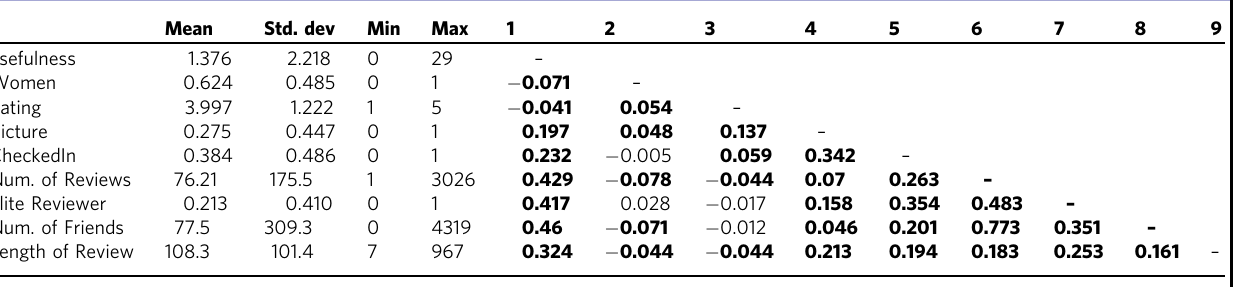
Table 2 Yelp data variable summary statistics and pearson correlations.